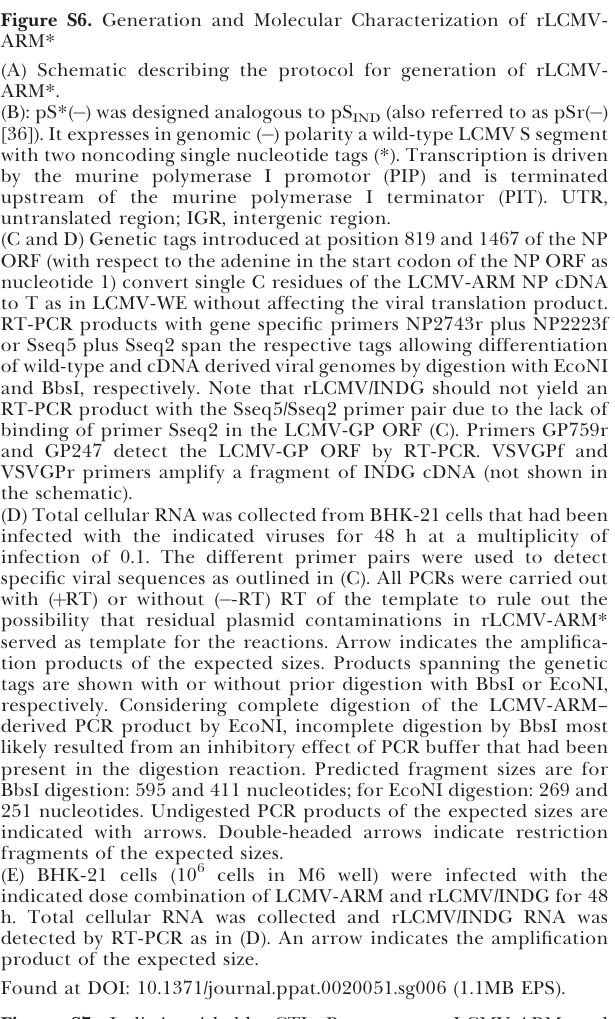
Figure S6. Generation and Molecular Characterization of rLCMV- ARM* (A) Schematic describing the protocol for generation of rLCMV- ARM*.